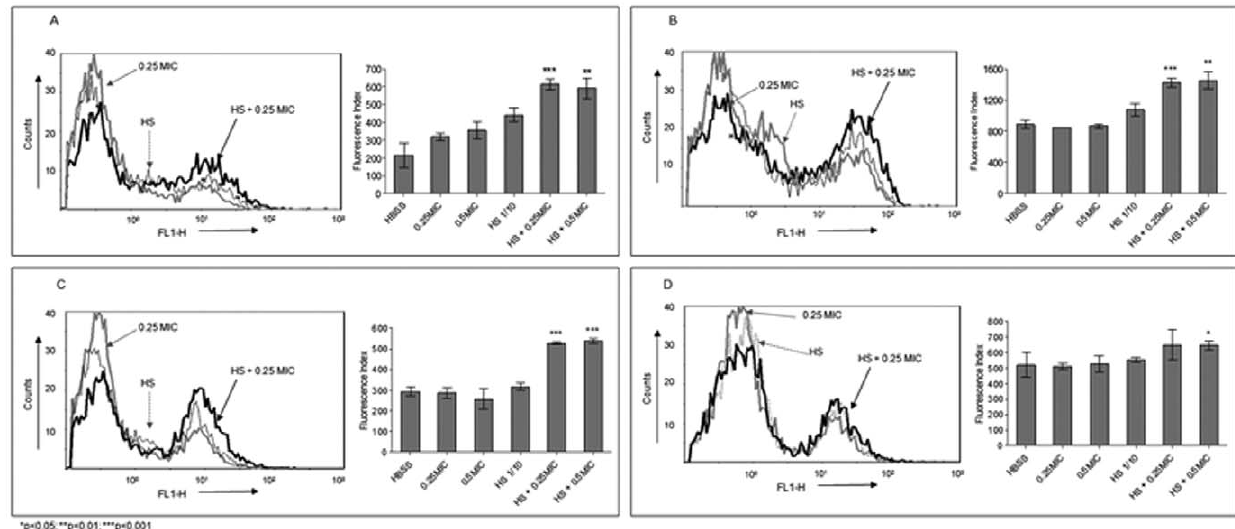
Figure 2. In vitro opsonophagocytosis using fresh mice neutrophils. Flow cytometry histograms and the corresponding fluorescence indices showing opsonophagocytosis for Strain 1 (A), Strain 3 (B), and Strain 2 with cefditoren (C) and ceftriaxone (D).